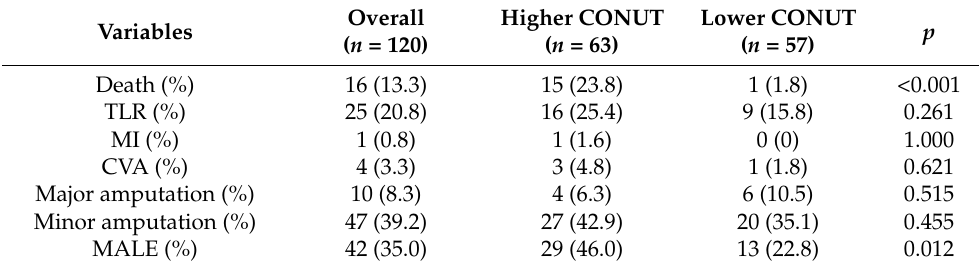
Table 3. Clinical outcomes at 12